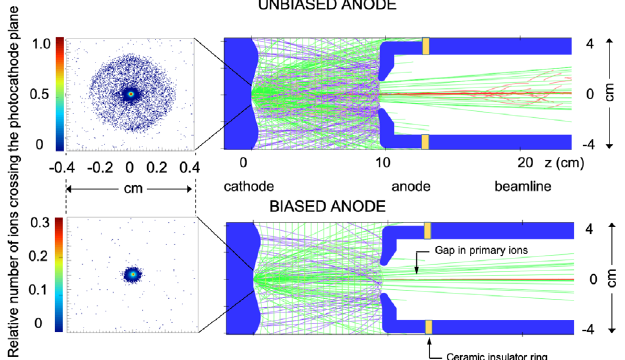
center.FIG. 13. IBSIMU simulation of the anode-cathode gap with the cathode electrode biased at − 300 kV for two cases: Top: unbiased anode, and bottom: anode biased at þ 1000 VDC. The left shows the relative number of ions and their x/y position on the photocathode plane. The right shows the trajectories of primary ions (red traces) generated by the main electron beam (not shown), secondary electrons (green traces) and secondary ions (purple ∇ 2 ϕ ¼ 0 on a mesh including the boundary conditions given by the biased anode and cathode electrodes and beam pipe.